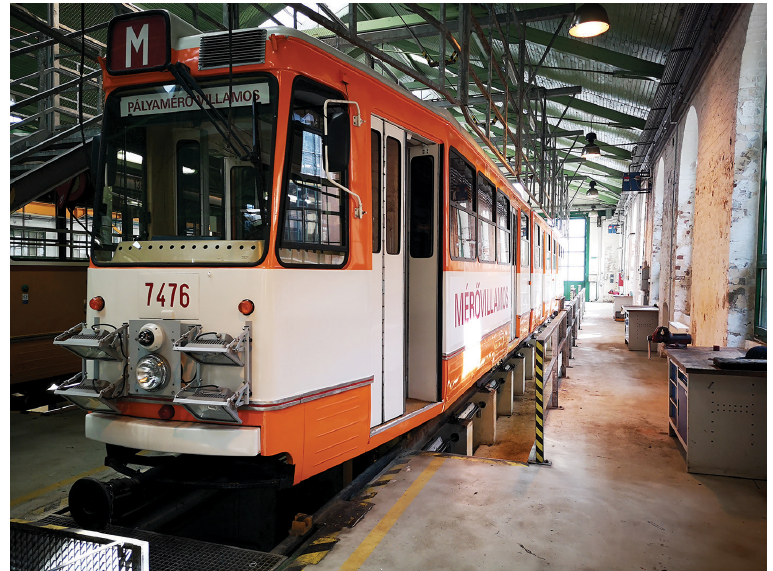
Figure 2. Instrumented in-service vehicle by BKV Zrt. and